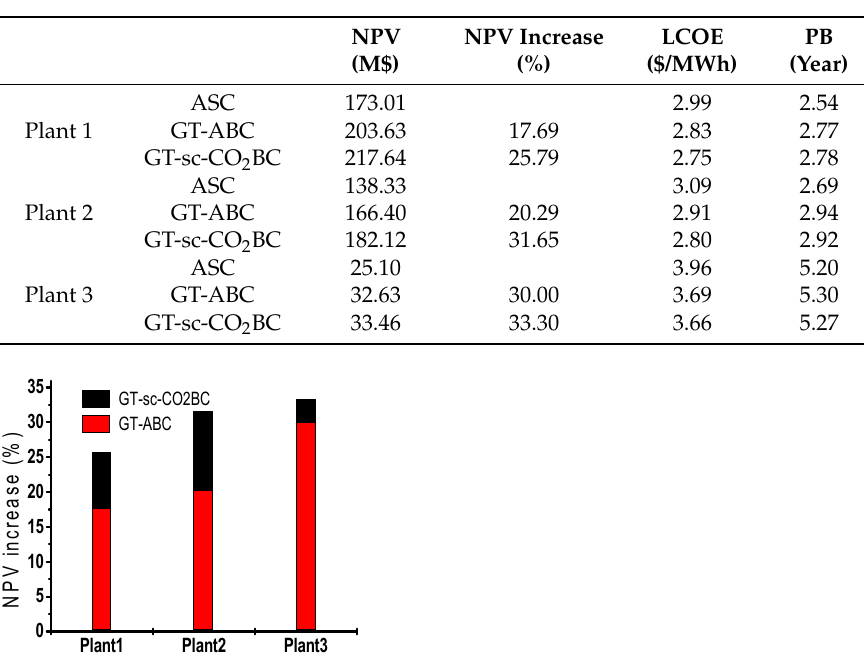
Figure 10. NPV increase obtained with GT-ABC and GT-sc-CO2BC compared with ASC.